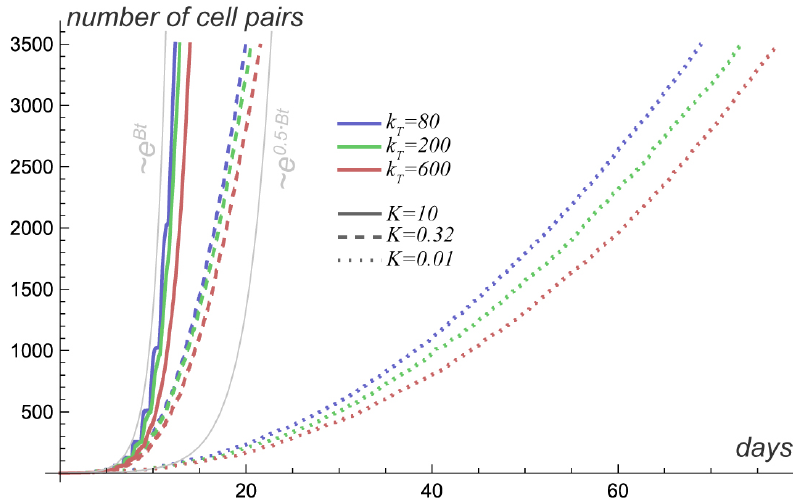
Figure 4. Dynamics of the number of tumor cell pairs under free tumor growth, with variations in the stress function coefficient k T and tissue conductivity K